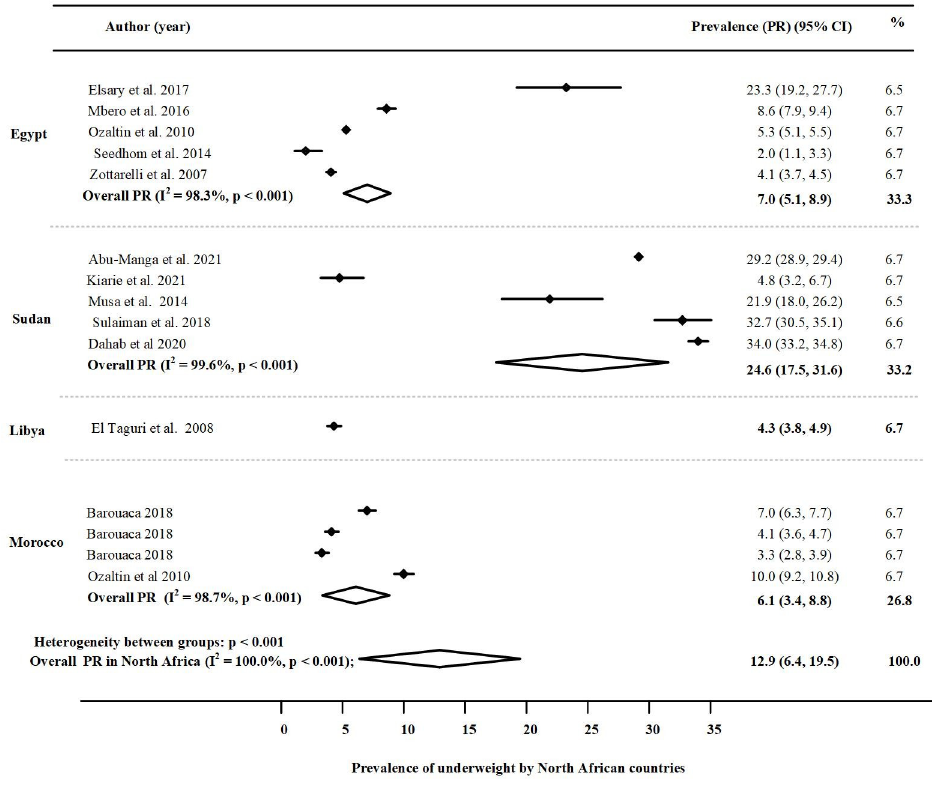
Fig 4. Prevalence of underweight in North Africa by